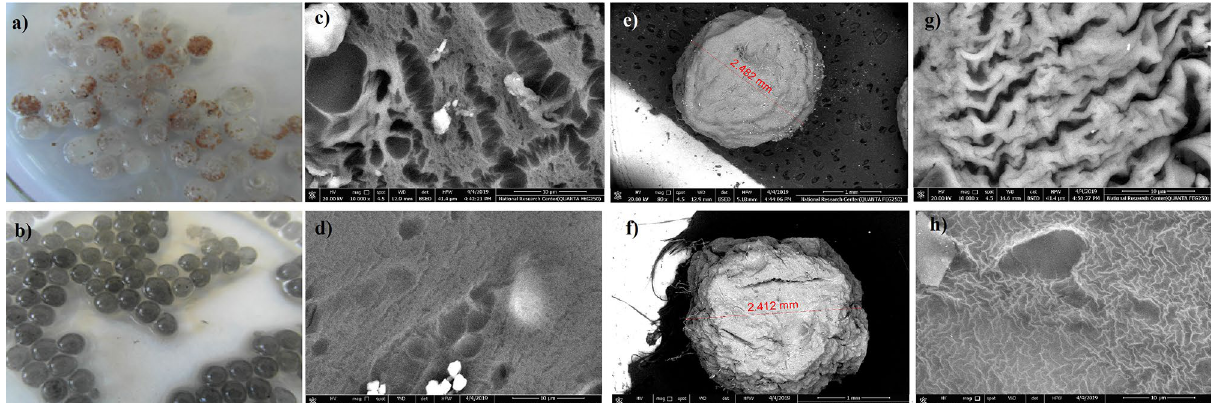
Figure 2. The SA ( a ) and SA-RGO ( b ) gel beads and their corresponding SEM images: surface of SA ( c ) and SA-RGO ( d ) gel beads with immobilized anammox biomass, image of single SA ( e ) and SA-RGO ( f ) bead and the surface of SA ( g ) and SA-RGO ( h ) control gel beads (without immobilized anammox biomass).